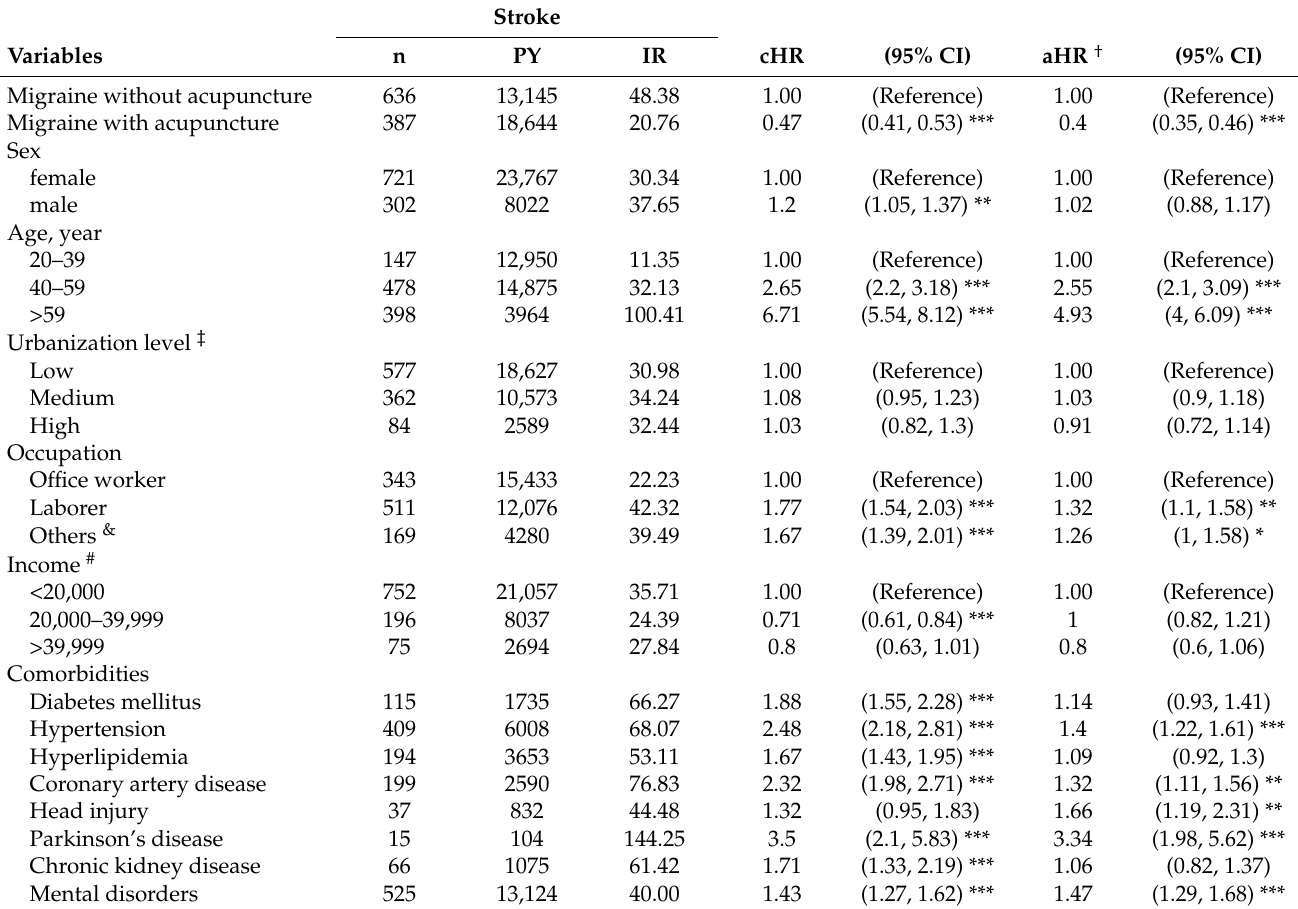
Table 2. Hazard ratios (HRs), and 95% confidence intervals (CIs) of strokes with covariates among patients with migraines in multivariable Cox proportional hazards